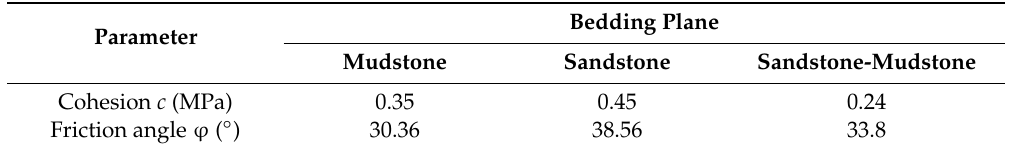
Table 2. Shear strength parameters of the bedding